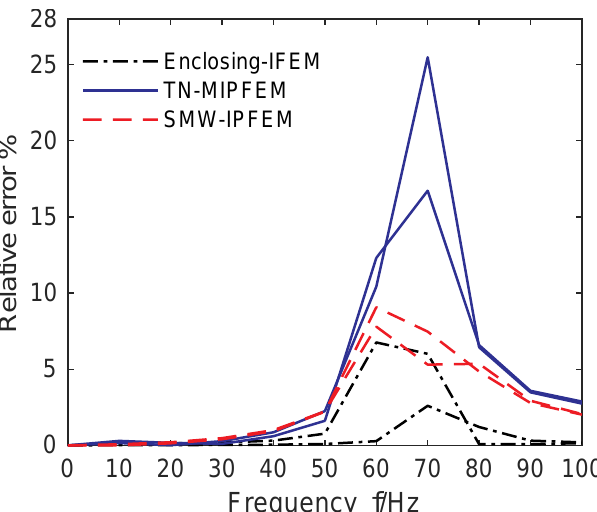
Figure 18. Comparison of the relative errors of different IFEMs for the 2D interior-car vibro-acoustic coupling model at the receiving point of